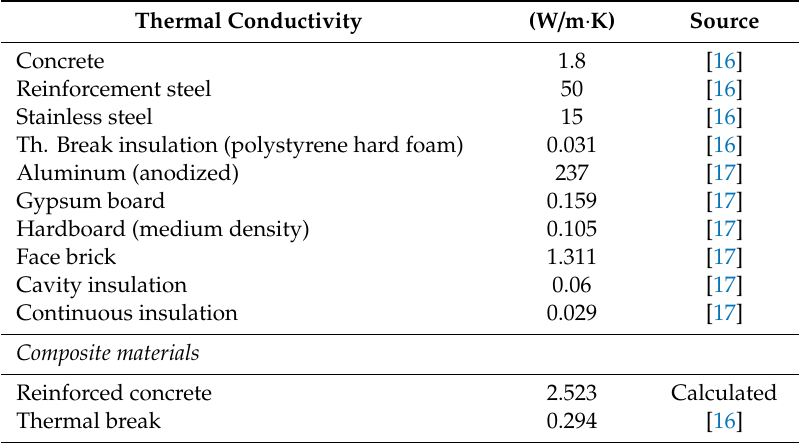
Table 1. Material thermal properties used in the THERM